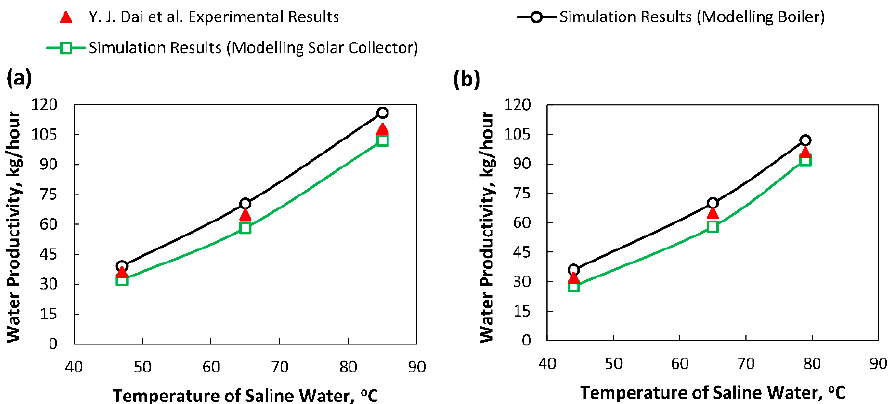
Figure 6. Comparison of simulation results with the experimental results of Dai et al. [75] for ( a ) case I, ( b ) case II, without waste heat recovery.